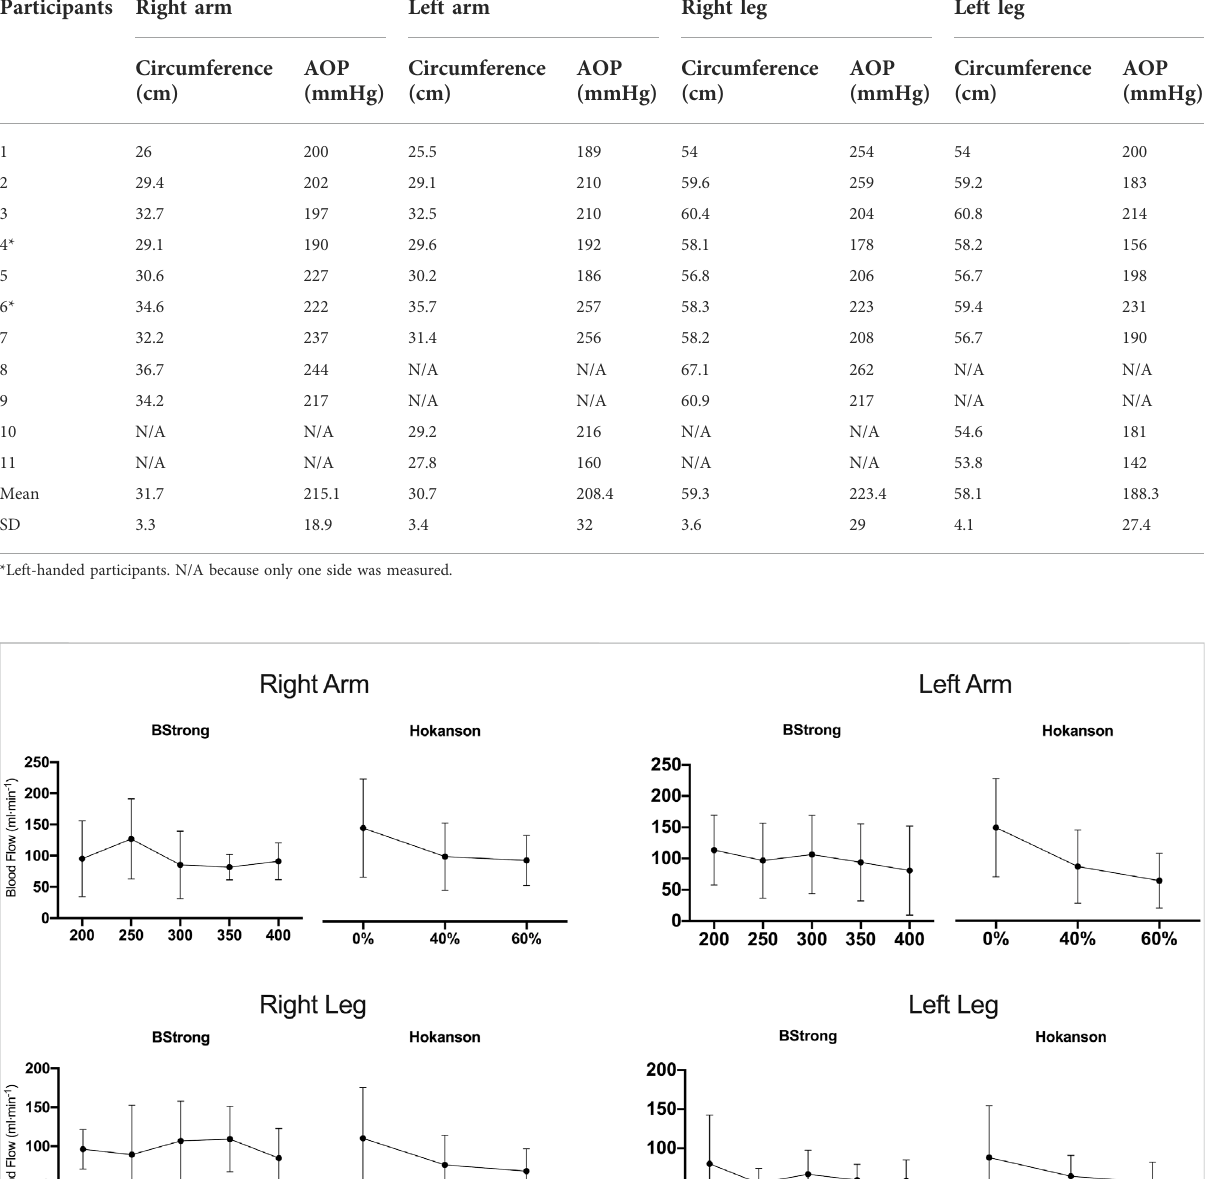
TABLE 1 Arterial occlusion pressures (AOP) measured at rest with Hokanson and circumference of participants ’ limbs. Participants Right arm